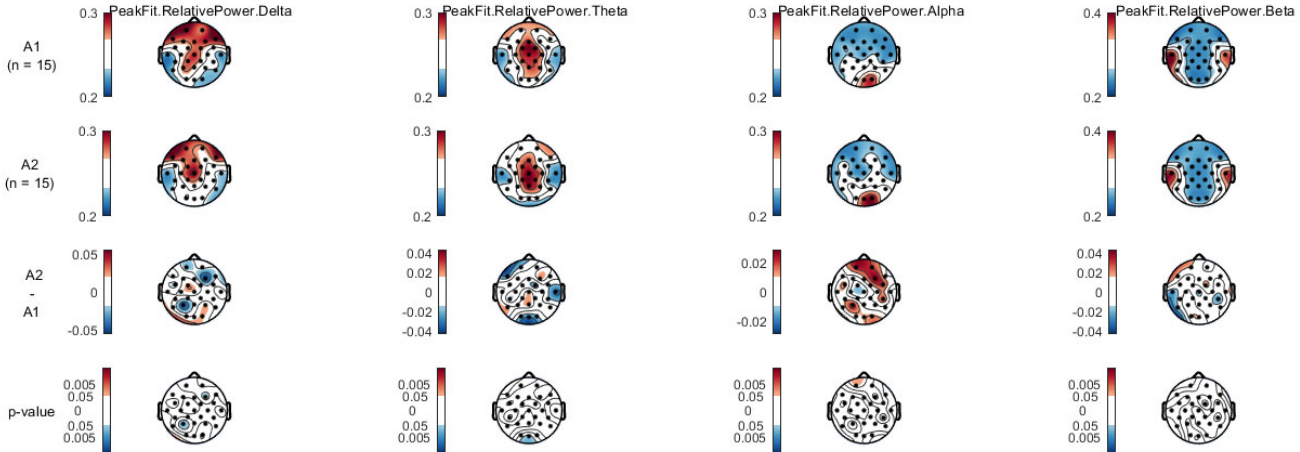
Figure 2. Scale map representation showing the differences between evaluation 1 (first line) and evaluation 2 (second line) for the 12 RM condition.